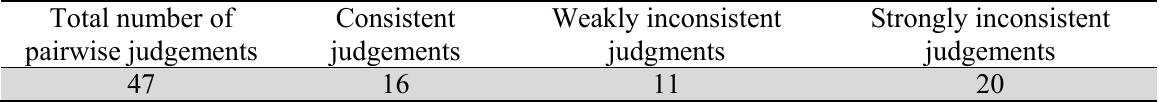
Number of inconsistent judgements Total number